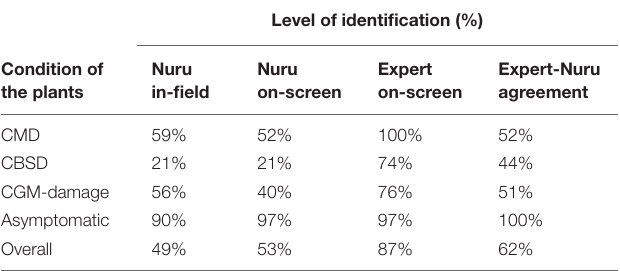
TABLE 2 | Comparison of in-field and on-screen capacity of the PlantVillage Nuru app to identify symptoms of CMD, CBSD, and CGM-damage as well as no symptoms on plants identified by experts as affected by CMD, CBSD, CGM or